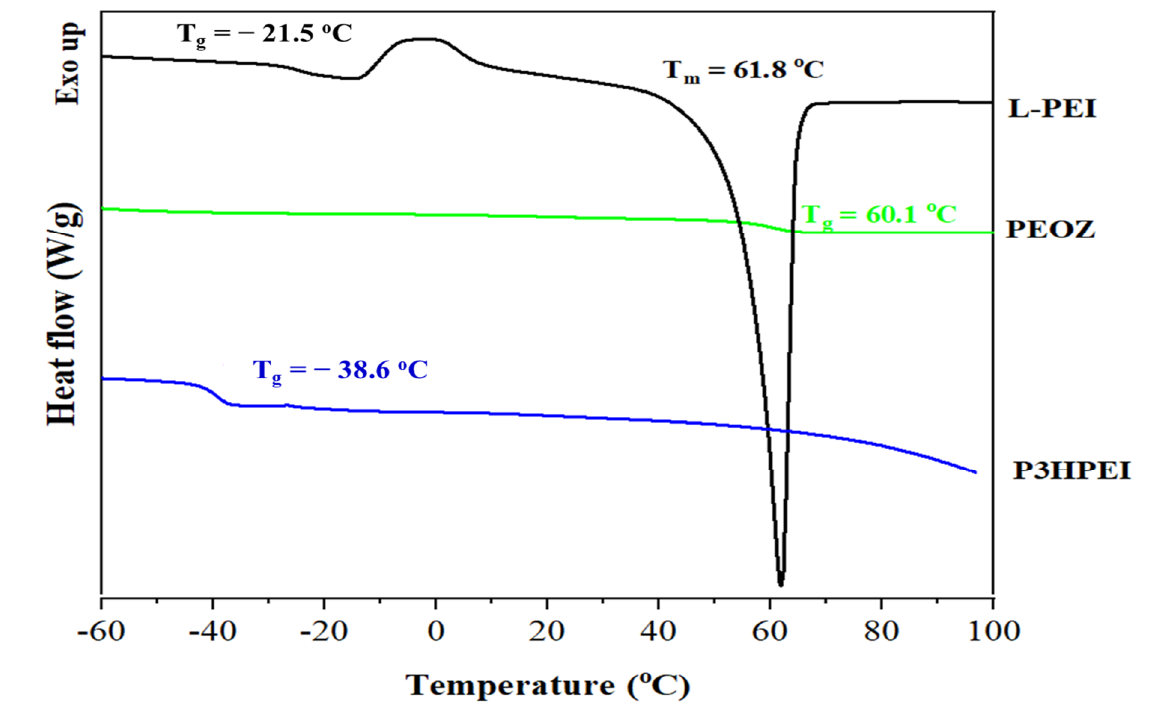
Figure 3. DSC thermograms of PEOZ, L-PEI, and P3HPEI.